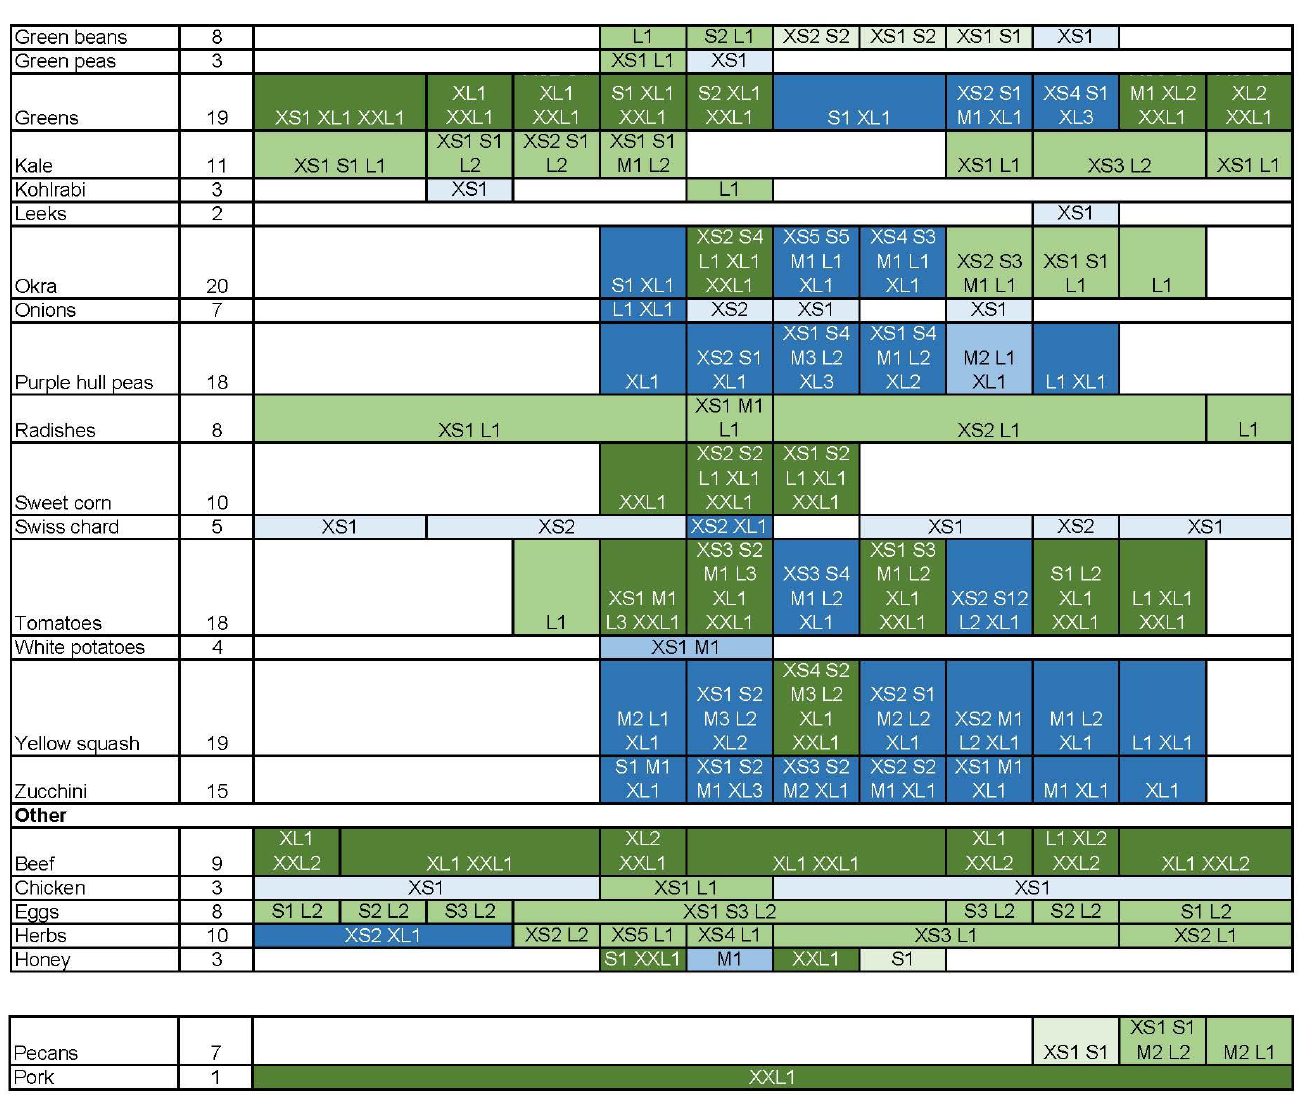
Figure 1. Small farm products (rows) by amount (S, M, L, XL, XXL; individual cells), harvest month (Jan–Dec; columns), and number of farmers (numbers 1–12 after amount letter; individual cells). Numbers may be less than N due to missing data or may exceed N due to multiple months chosen. were missing. XS = extra small amount (1–50 pounds); S = small amount (51–100 pounds); M